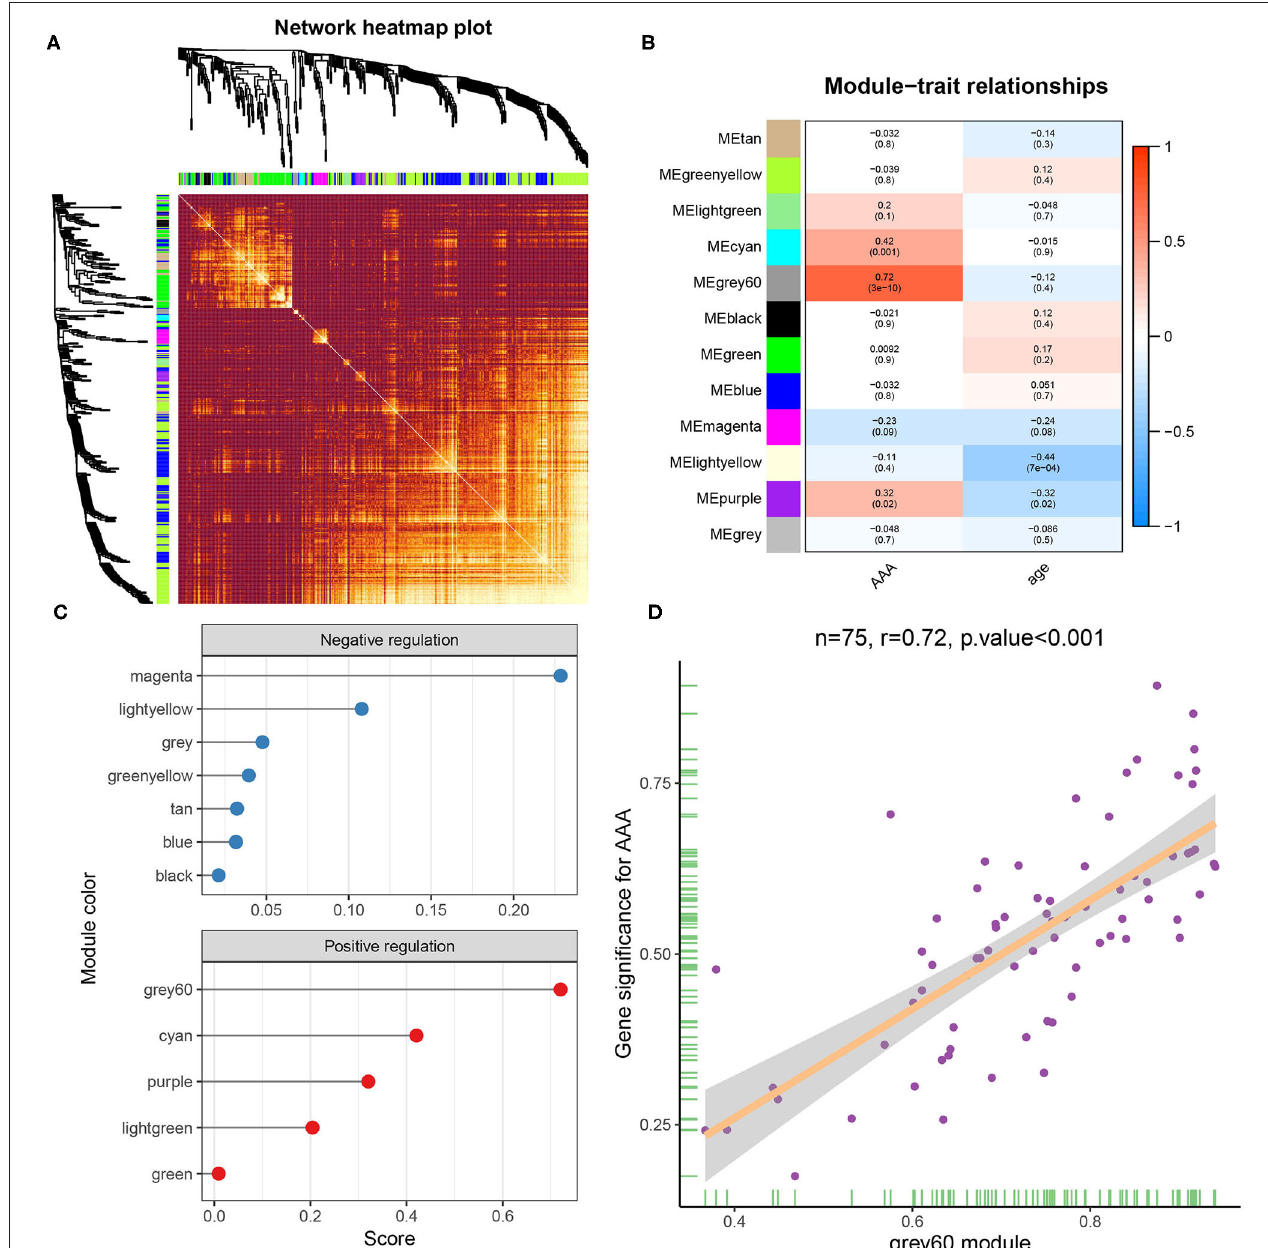
FIGURE 3 | Gene module analysis based on WGCNA. (A) Heatmap of TOM of genes which selected by WGCNA. (B) Heatmap between gene modules and clinical characteristics. (C) Correlation score of modules with adipose tissue around AAA. (D) Correlation analysis between genes in grey60 module and adipose tissue around